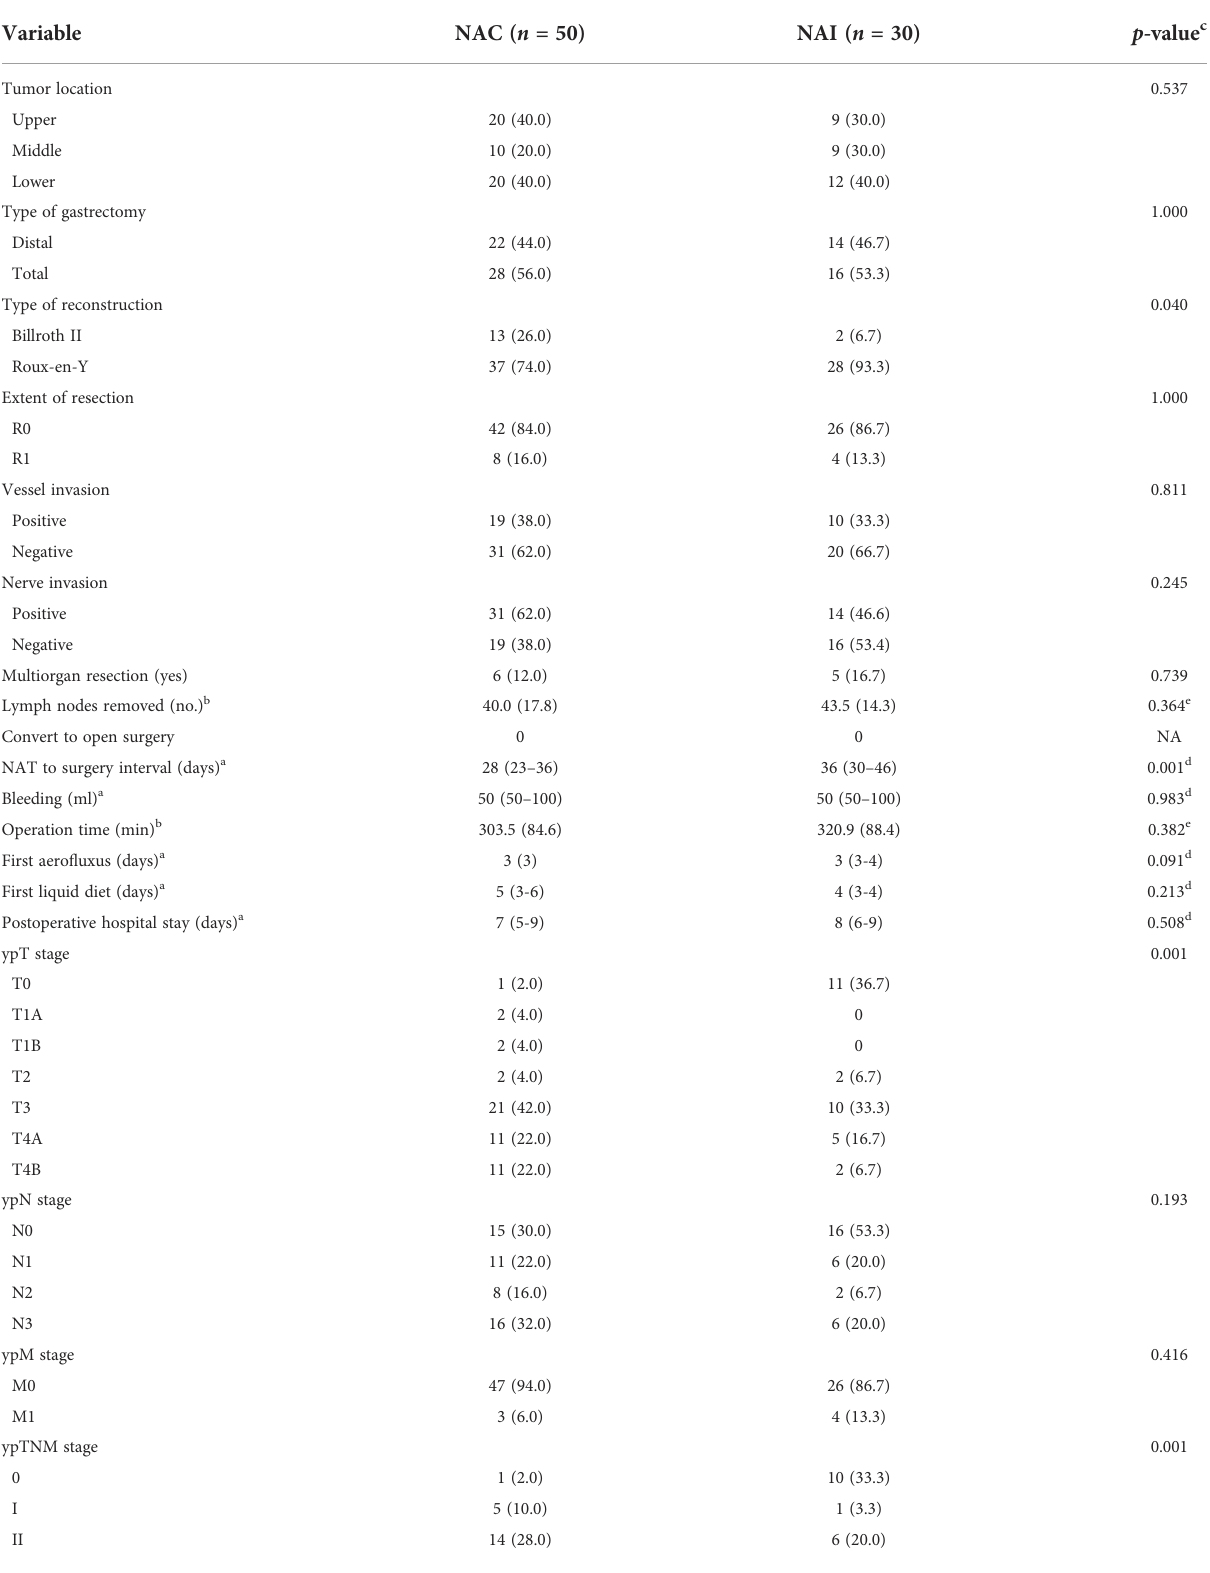
TABLE 3 Surgical, postoperative recovery, and pathological results of two